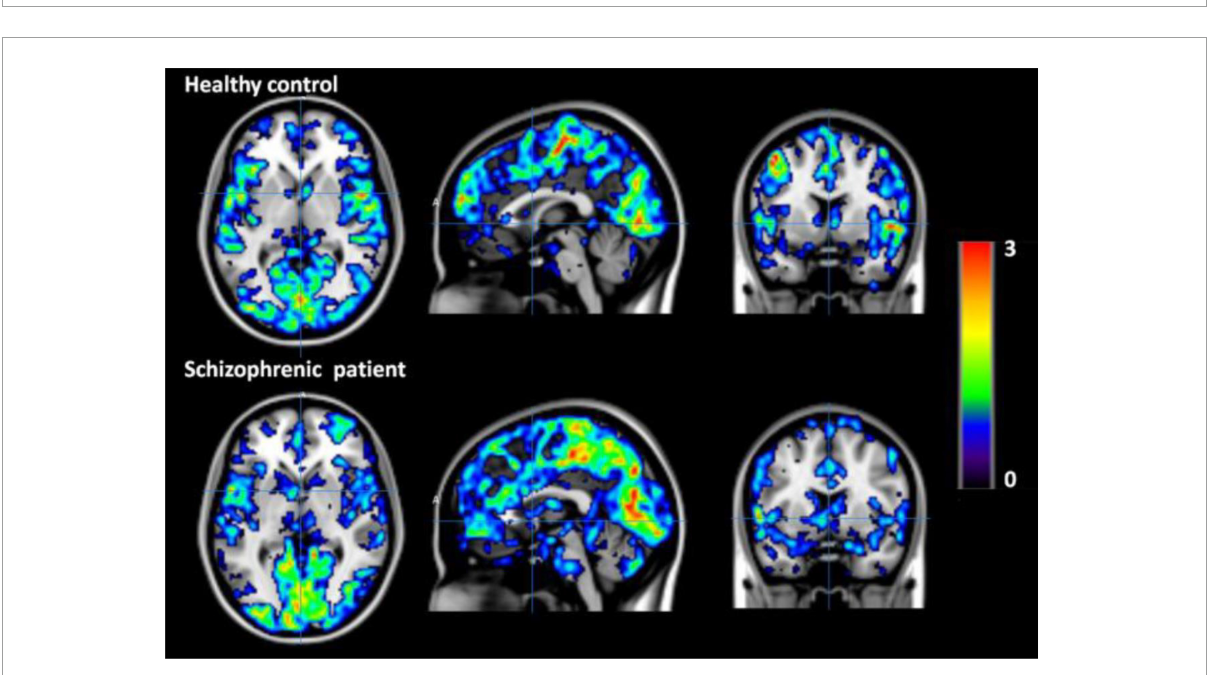
FIGURE13 fMRI Degree Centrality (DC) values of healthy control (top row) and schizophrenic patient (bottom row) during first resting state measurement. The DC values are overlaid on the MNI template. DC is one of the data driven functional connectivity measures and is computed using rs-fMRI data from both the healthy control and the schizophrenic patient (Neuner et al.,